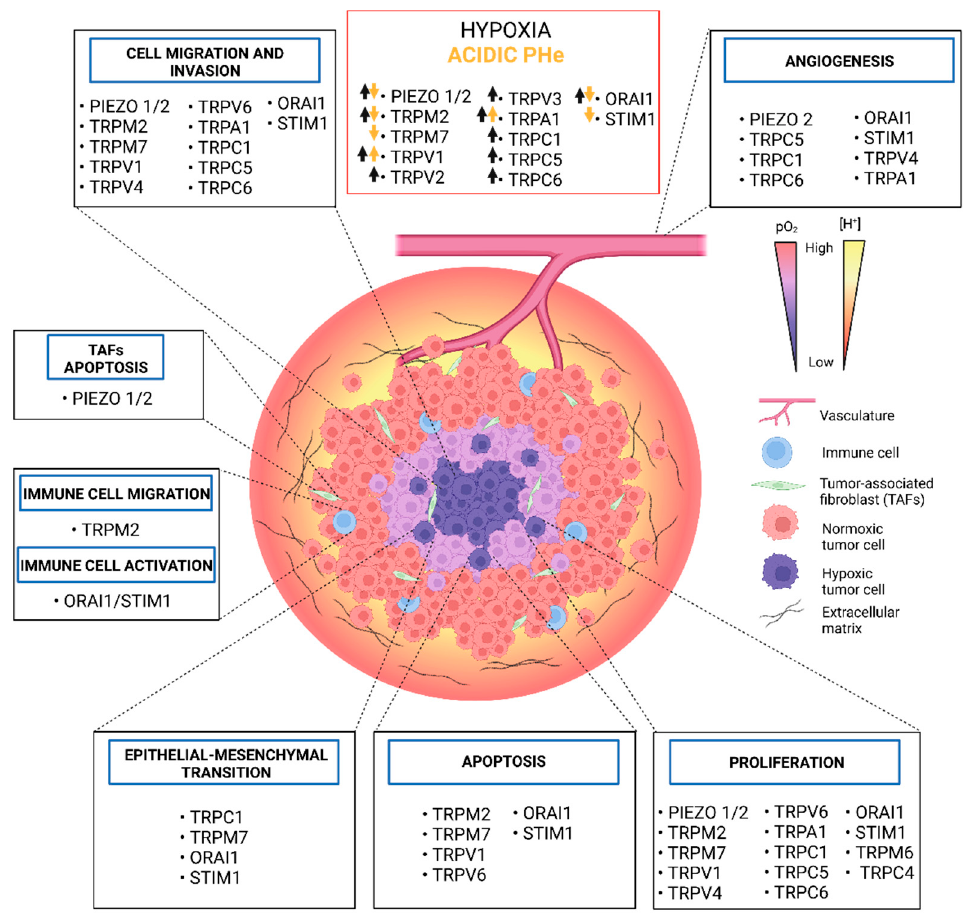
Figure 3. Schematic illustration of tumour microenvironment landscape. The increased tumour growth, the acidification of the extracellular space and aberrant vascularisation and limited O 2 supply origin a tumour core that is hypoxic and acidic, with limited supply of oxygen and nutrients from the blood vessels. Peripheral tumour cells are located in regions with a higher extracellular pH, a result of proximity to blood vessels and the possibility to wash out acidic waste products. TRP, Piezo and SOCs channels expressed in cancer, immune and stromal cells are presented in the corresponding black boxes with indication of their involvement in different cancer hallmarks, such as proliferation, migration, invasion, angiogenesis, and epithelial–mesenchymal transition. The red box contains the up-to-date information regarding the effect (up arrows = positive effect; down arrows = negative effect) of hypoxia and acid pH e on the activity and/or expression of calcium-permeable channels in cancer cells or tumour-associated cells.